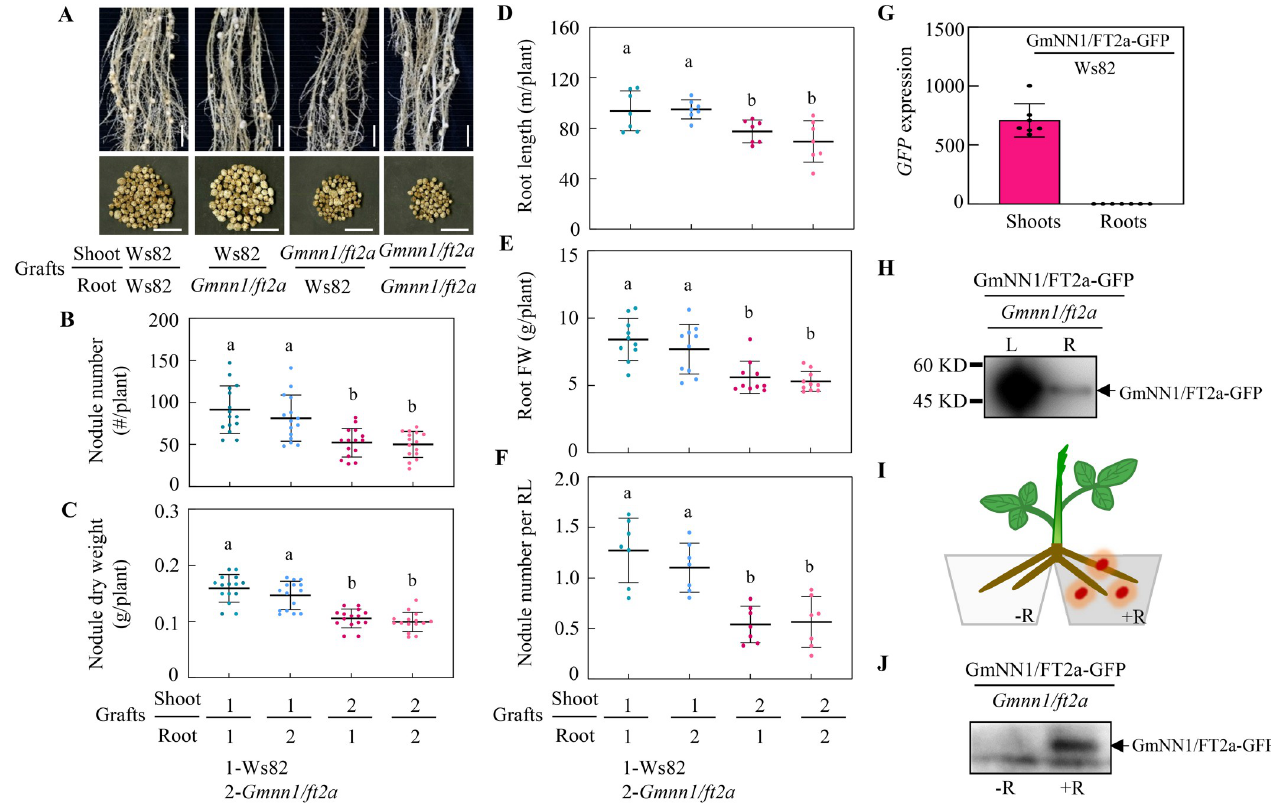
Fig 4. Shoot-to-root translocation of GmNN1/FT2a regulates soybean nodulation. (A) Phenotype of nodulation from reciprocal grafting between Ws82 and Gmnn1 / ft2a mutant plants. Scale bars, 2 cm. (B) Nodule number from grafts ( n = 15). (C) Nodule dry weight ( n = 15). Values are the means from 2 independent experiments. (D) Root length ( n = 7). (E) Root FW ( n = 10). (F) Nodule number per RL ( n = 7). The reciprocal grafting plants were harvested at 21 dai. (G) Transcript abundance of GmNN1/FT2a-GFP in shoot-root grafts at 5 dai ( n = 7). GmNN1/FT2a-GFP: stable transgenic soybean; Ws82, WT control. (H) Immunological detection of GmNN1/FT2a-GFP in leaves (L) and roots (R) of grafts at 5 dai. Scions and rootstocks were stable transgenic soybean plants harboring GmNN1/FT2a-GFP and a knockout of GmNN1/FT2a ( Gmnn1 / ft2a ), respectively. (I ) Diagram of split-root experiment. (J ) Immunological detection of GmNN1/FT2a-GFP from split roots 5 dai with (+R) or without ( − R) rhizobia. All data are given as mean ± SD. Different letters denote significant differences ( P < 0.05) according to Duncan’s multiple range comparison tests. Data underlying the graphs in the figure can be found in S1 Data. dai, day after inoculation; FW, fresh weight; RL, root